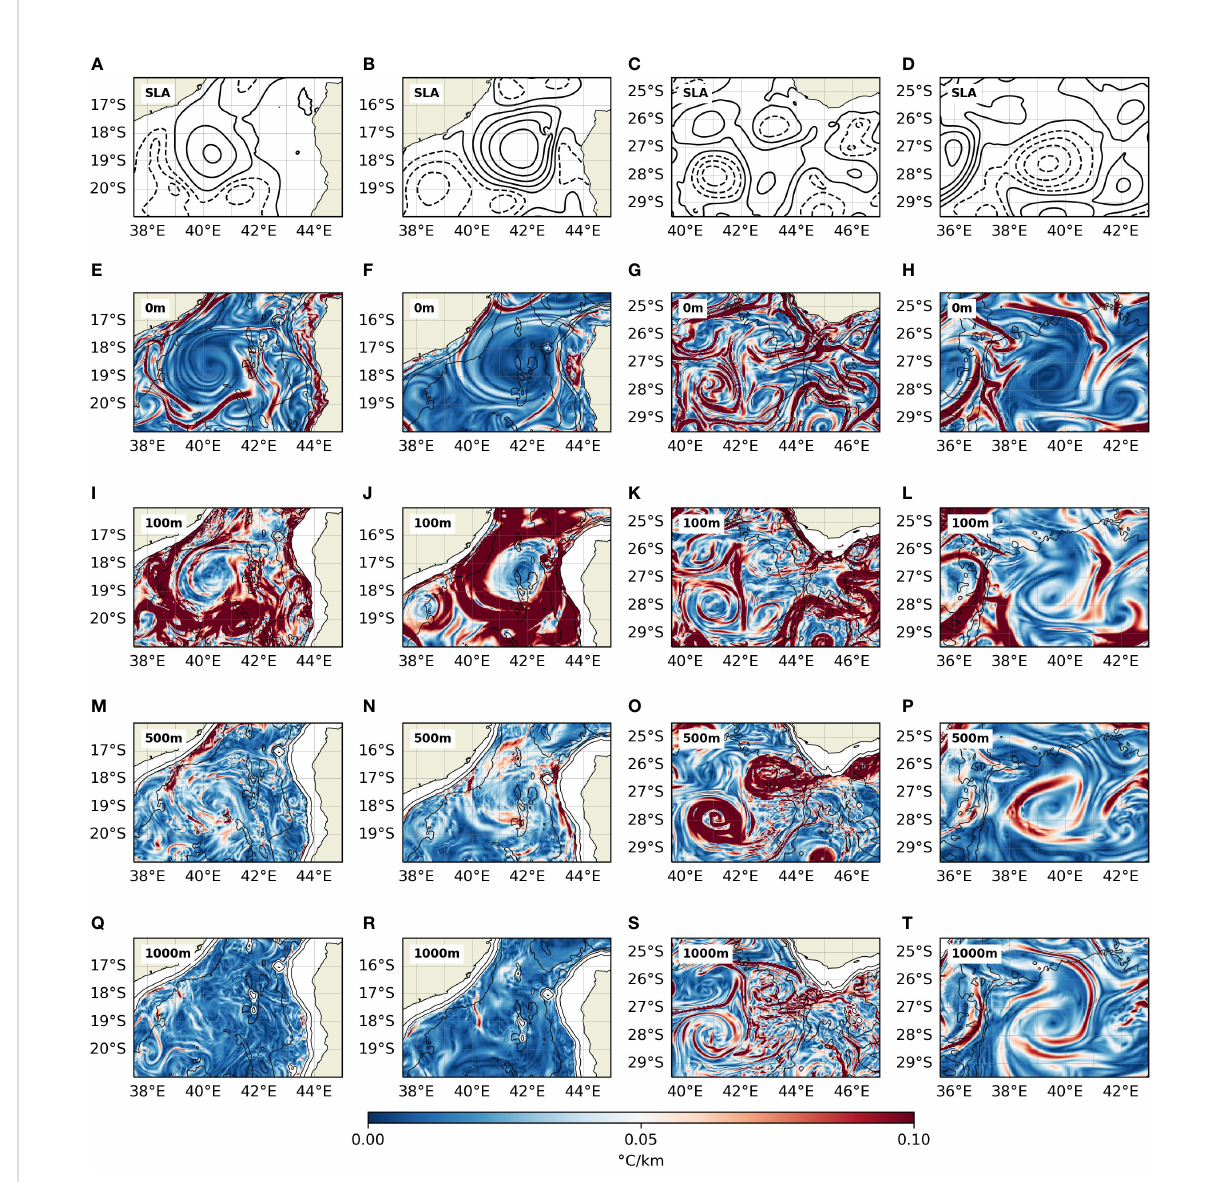
FIGURE 5 Selected snapshots comparing the vertical structures of anticyclonic ( fi rst 2 columns: A, B, E, F, I, J, M, N, Q, R ) and cyclonic (last 2 columns: C, D, G, H, K, L, O, P, S, T ) eddies from MOZ36. Each column represents a different eddy structure. The fi rst row corresponds to sea-levels anomalies relative to mean sea-surface height, full (dashed) lines are positive (negative) anomalies. Rows 2, 3, 4 and 5 are temperature front intensities in °C/km, at surface, -100 m, -500 m, -1000 m respectively.